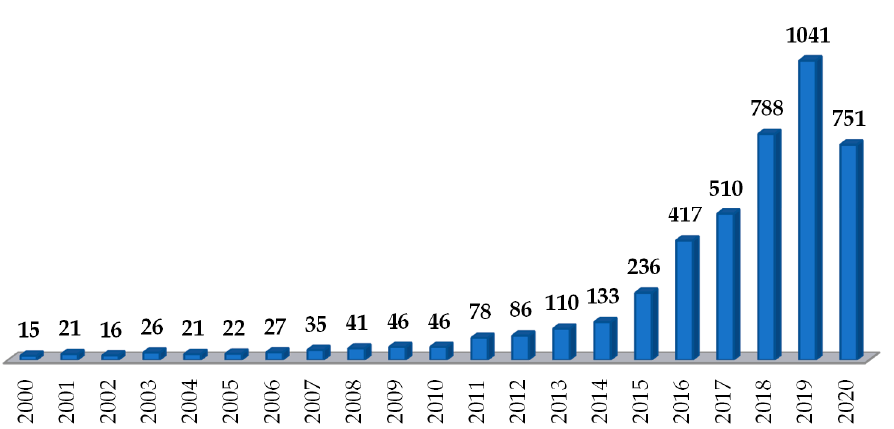
Figure 1. Number of publications relating to 3D printing of medicines over the last 20 years (ScienceDirect ® ).